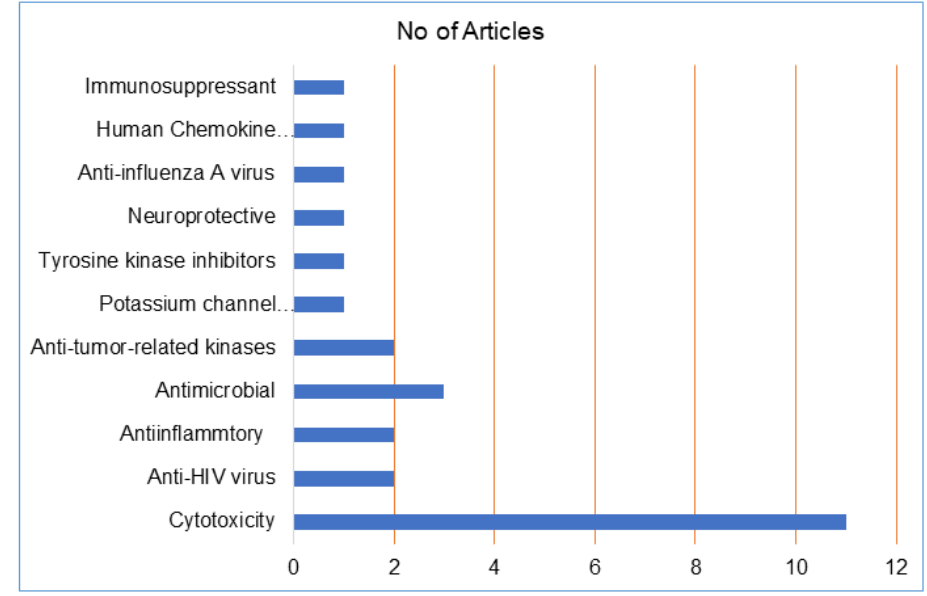
Figure 29. Biological activities of reported metabolites and the number of articles.